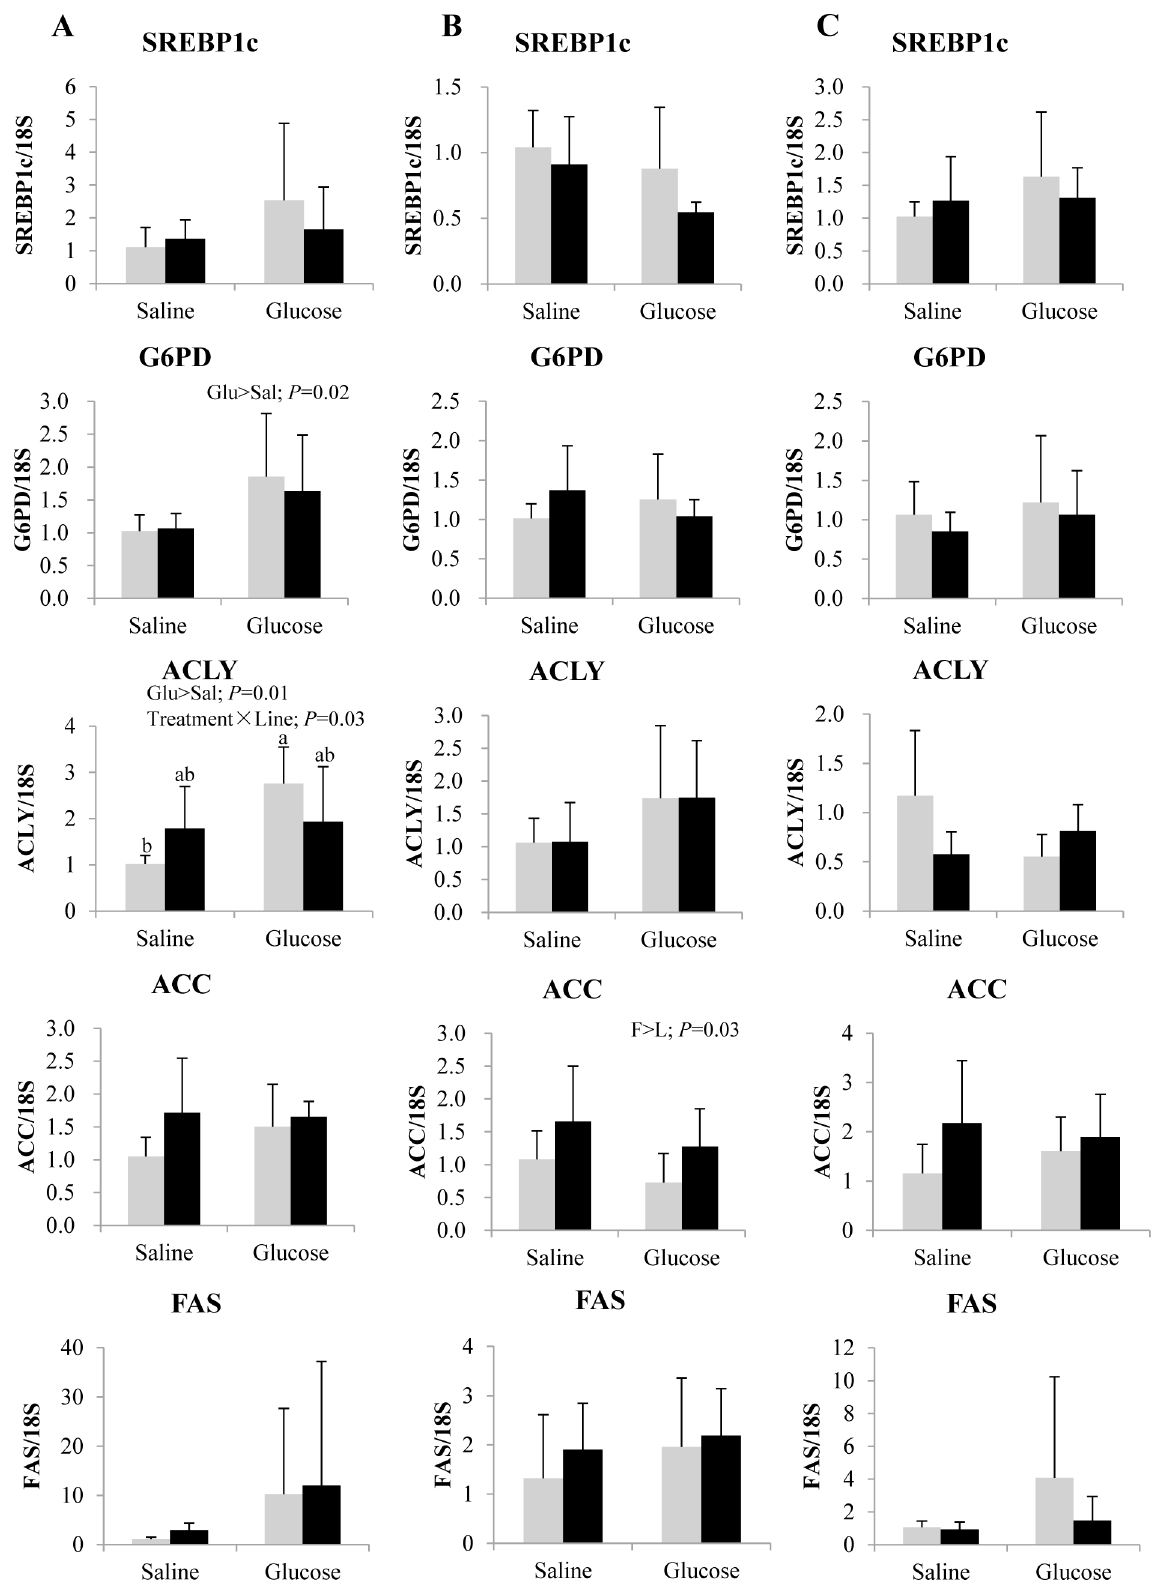
Figure 6. Gene expression of selected transcription factors and enzymes involved in NADPH generation and lipogenesis in the liver of rainbow trout from L line (L; grey bars) and F line (F; black bars) at 3 h (A), 8 h (B) and 12 h (C) after IP administration of glucose or saline solution. Sterol regulatory element binding protein 1c (SREBP1c), glucose 6-phosphate dehydrogenase (G6PD), ATP citrate lyase (ACLY),